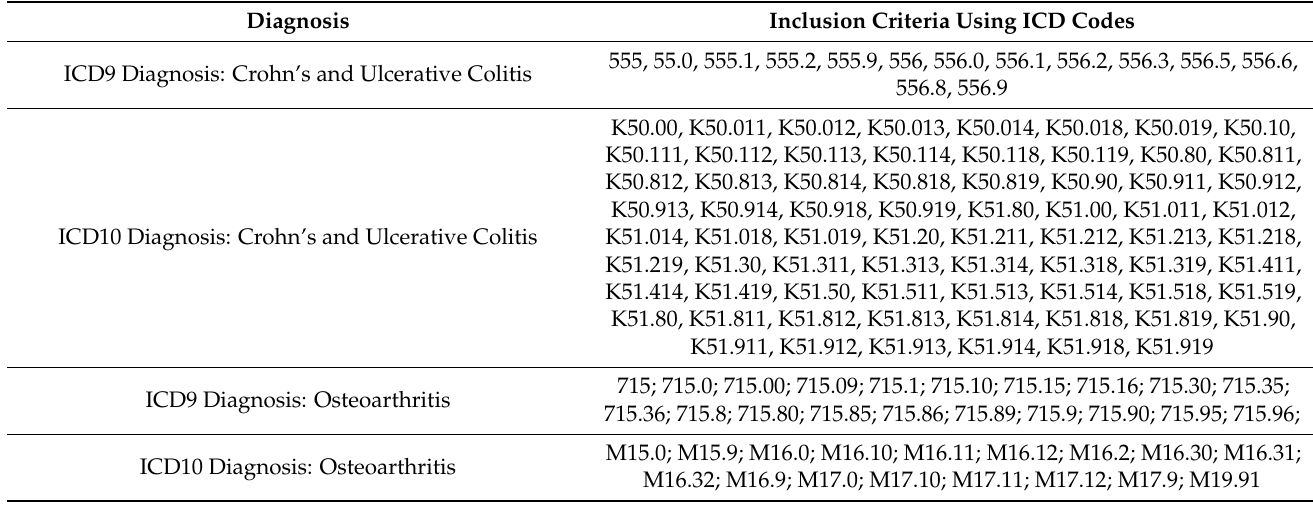
Table A1. Diagnosis codes used for inflammatory bowel disease and